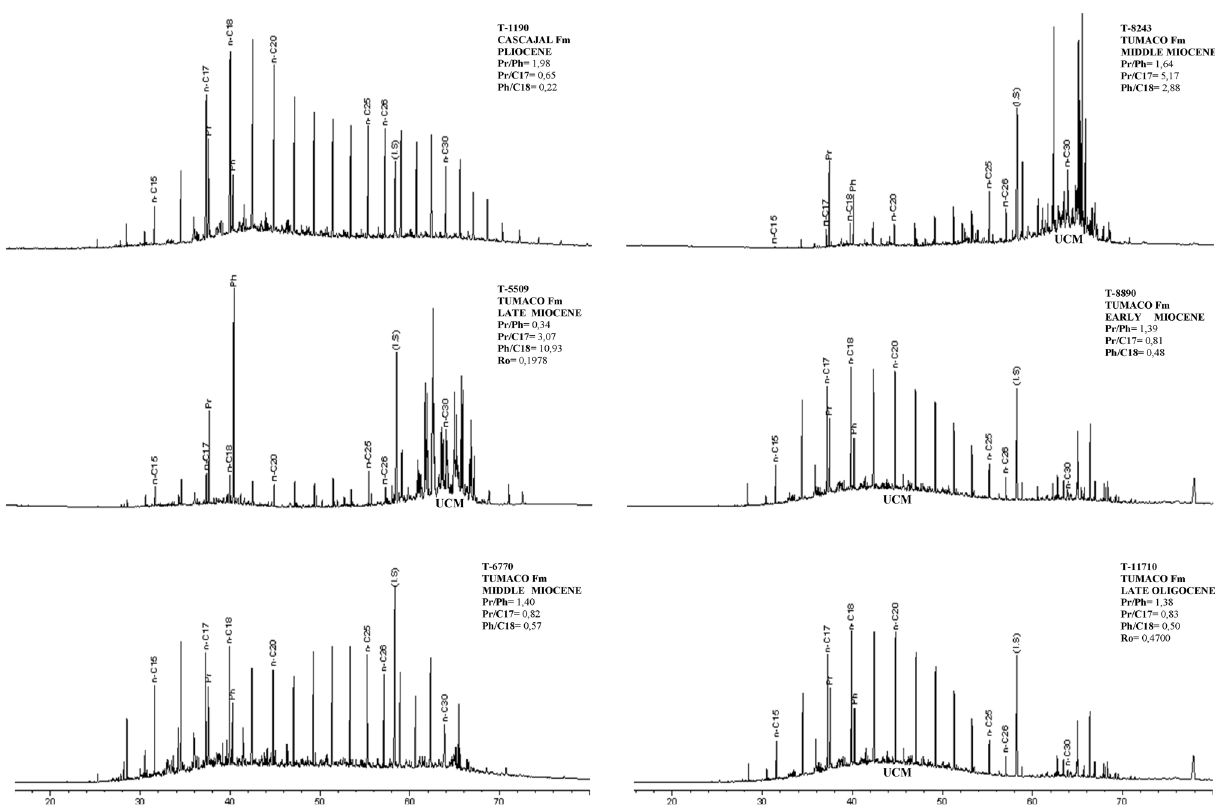
Fig. 10 GC/FID C15 + chromatograms of saturate fractions of selected rock extracts in the Tumaco-1-ST-P, Tumaco basin,